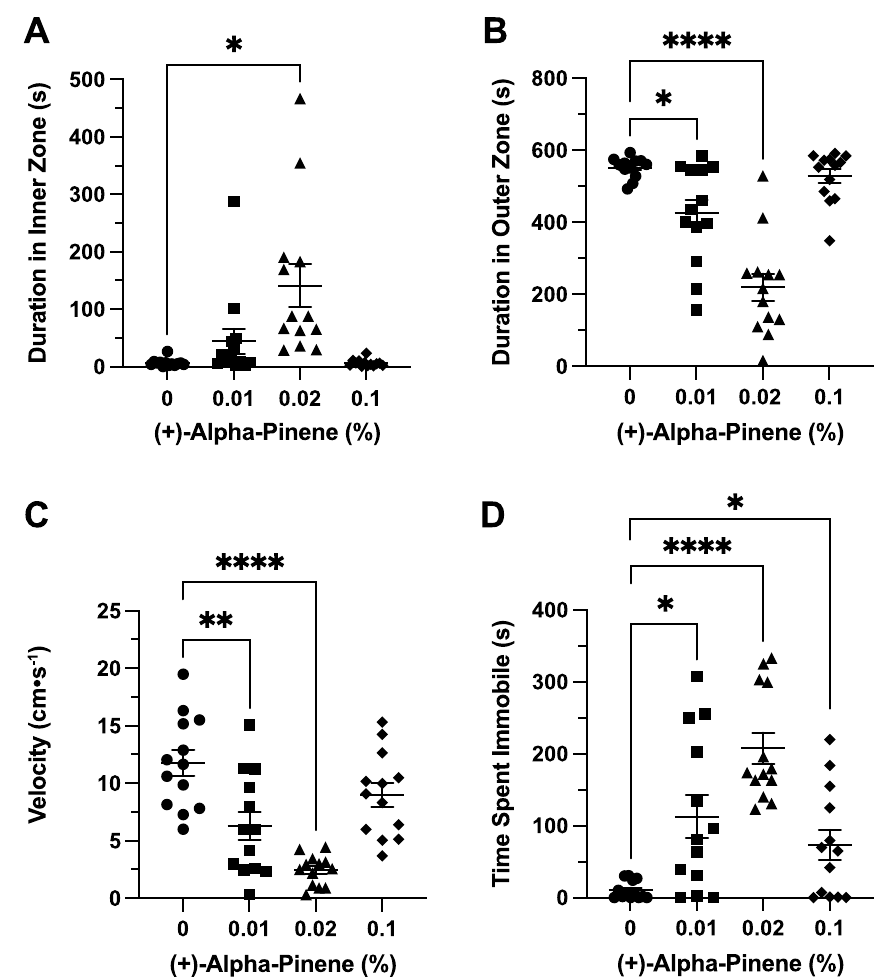
Figure 6. The effects of (+)-alpha-pinene administration in the open field test. Average duration of time fish spent in the ( A ) inner and ( B ) outer ‘thigmotaxis’ zone during the open field test. Fish locomotion was quantified in the open field test by measuring ( C ) swimming velocity and ( D ) time spent immobile. All data are presented as mean ± S.E.M. Significant differences between controls and (+)-alpha-pinene treated groups are indicated by *( p < 0.01), **( p < 0.001), and ****( p <